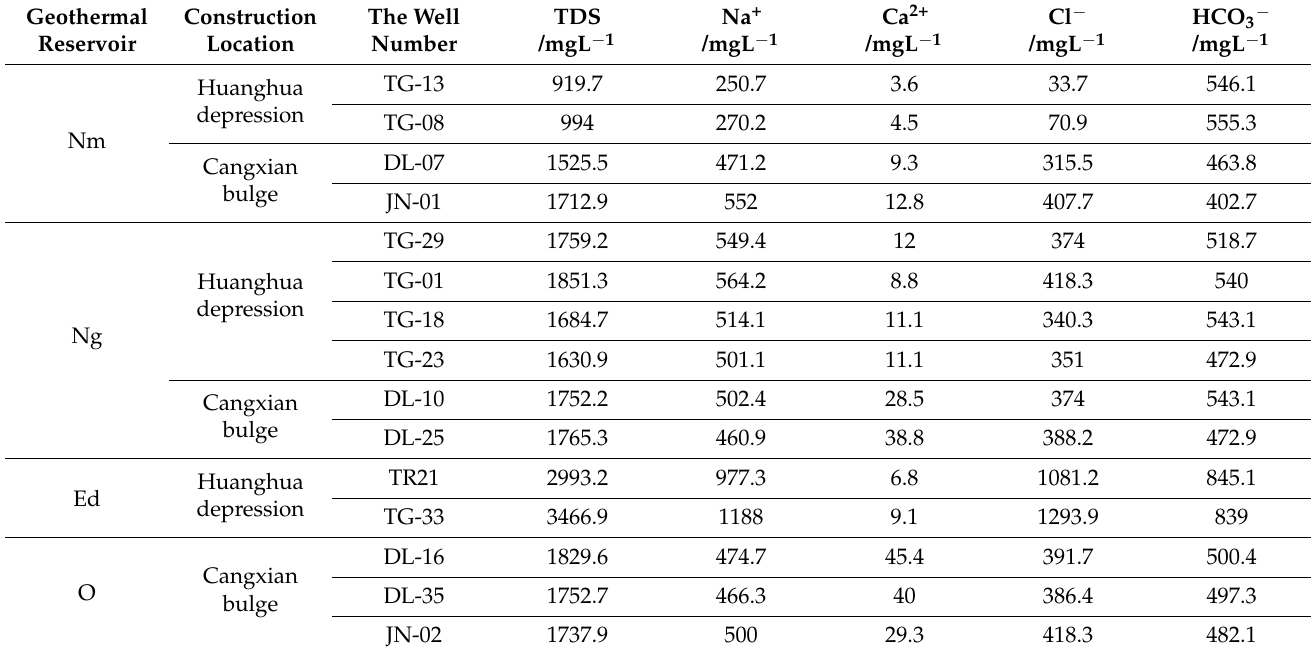
Table 5. Correlation table of main chemical composition of the geothermal fluid in each geother- mal